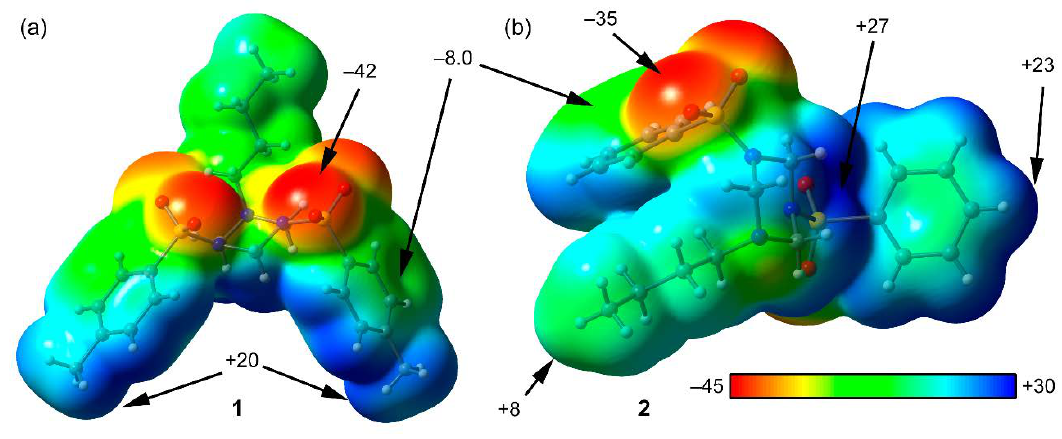
Figure 8. MEP surfaces for compounds 1 ( a ) and 2 ( b ). The energies at selected points of the surfaces are given in